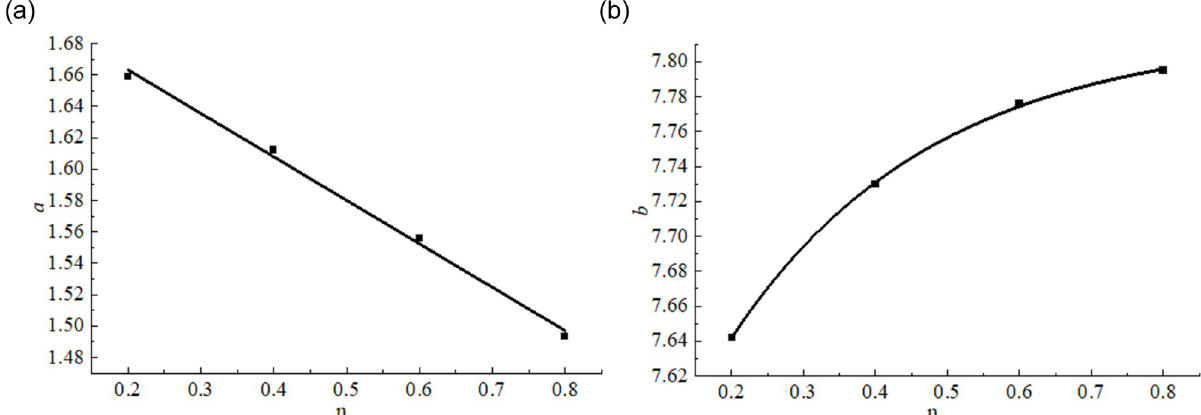
Fig 6. Relationship between the compaction parameters and n . (a) Relationship curve between a and n . (b) Relationship curve between b and n .